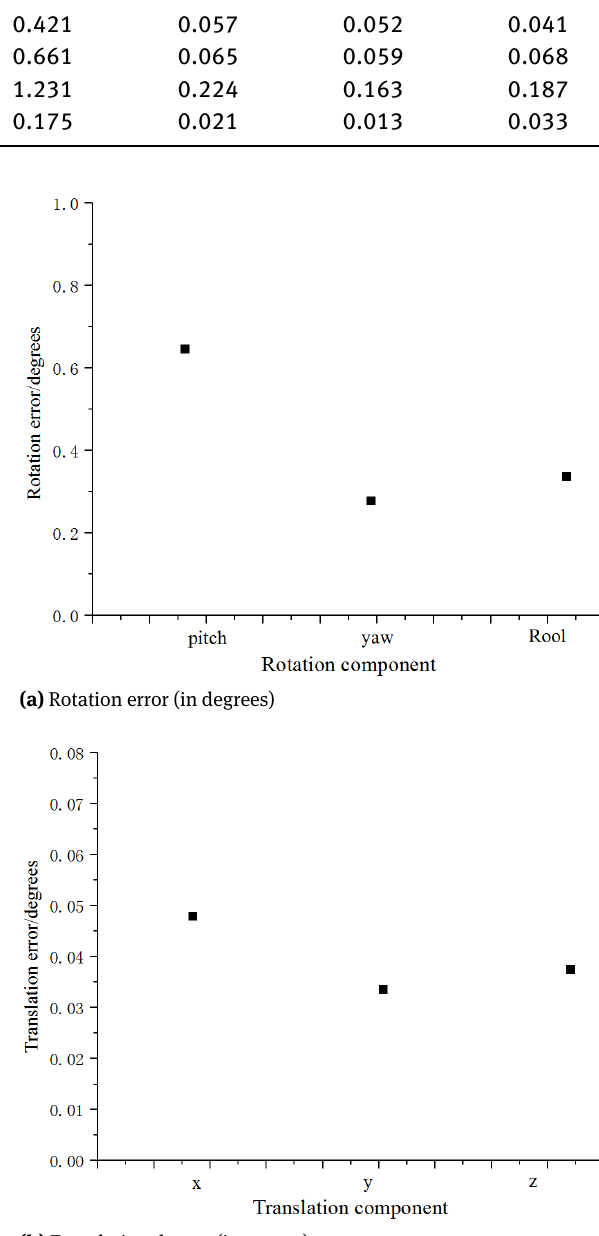
Figure 3: The errors observed for the method based on depth-edge matching